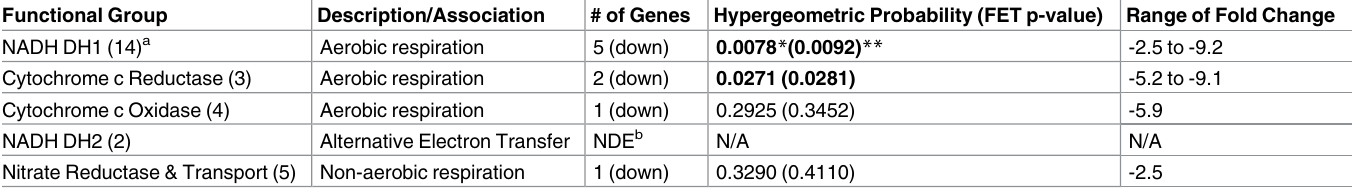
Table 3. Differentially expressedfunctional categories indicative of M . tb respiratory state. Functional